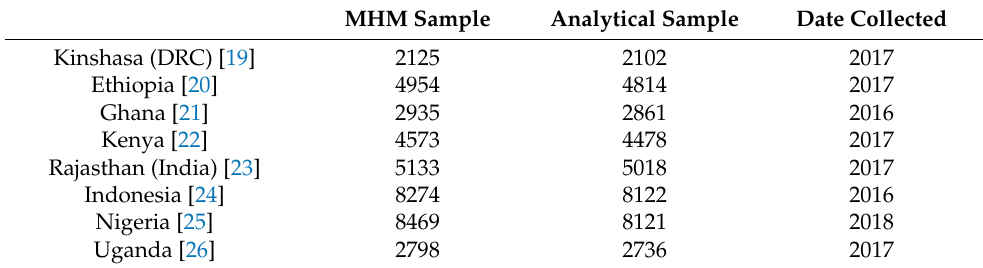
Table 1. PMA2020 sample statistics. MHM Sample Analytical